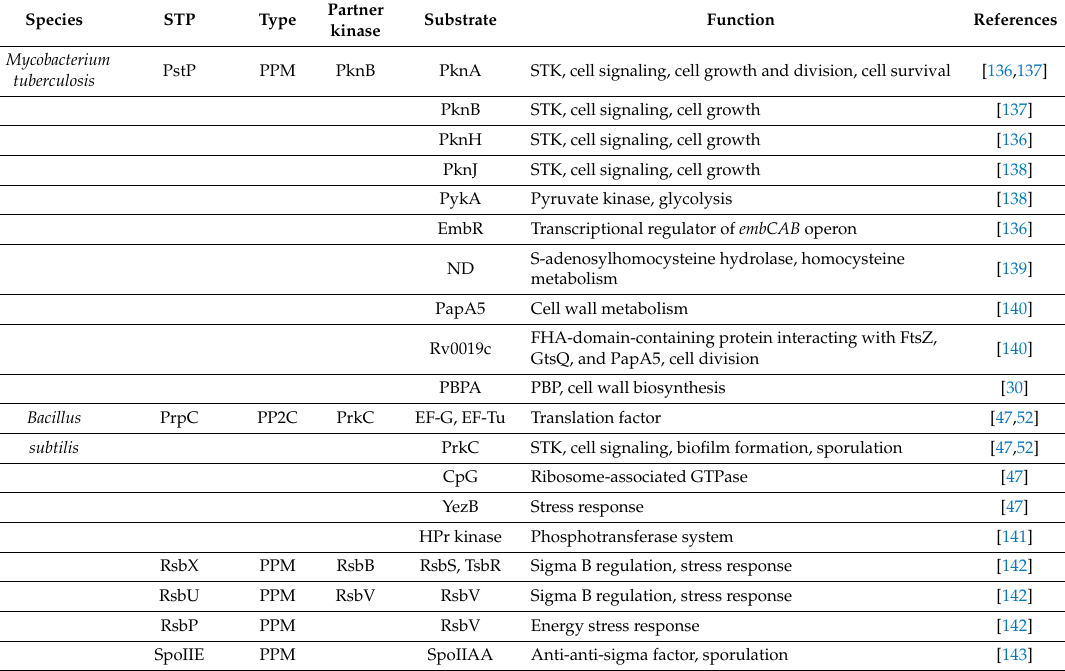
Table 2. Bacterial serine/threonine phosphatases (STPs), their substrates, and biological functions. Partner Species STP Type Substrate kinase